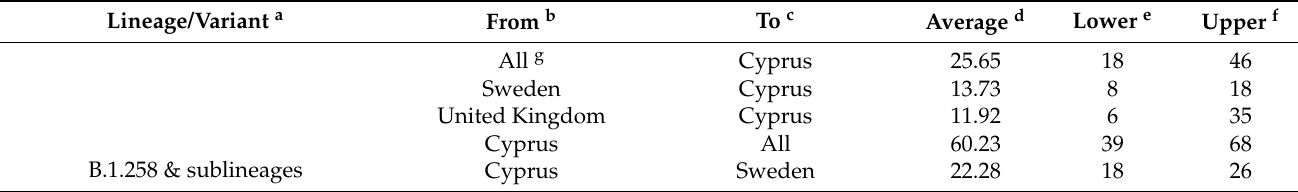
Table 2. The estimated number of migration events towards and from Cyprus. Lower and upper refer to the bounds of the 95% HPD interval.